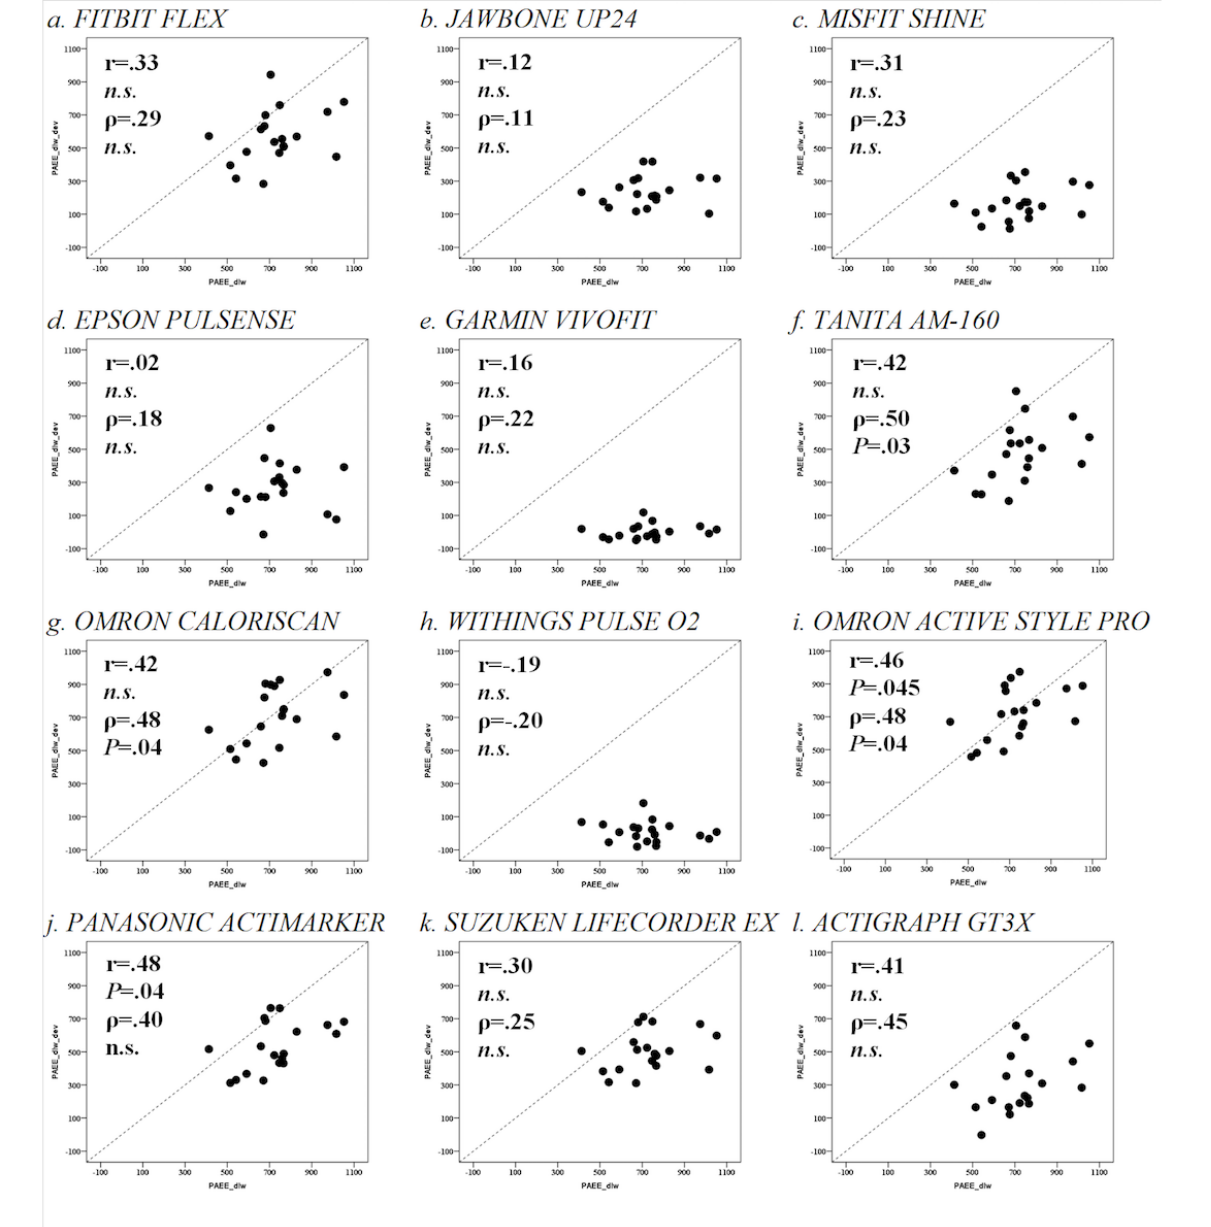
Figure 3. Correlation between PAEEdlw (physical activity energy expenditure) and PAEEdev during 15 free-living days. Scatter plots for PAEEdlw (x-axis) and PAEEdev (y-axis) during 15 free-living days. Upper and lower values for r and ρ resulting from Pearson and Spearman correlation tests, respectively, are shown. n.s.: